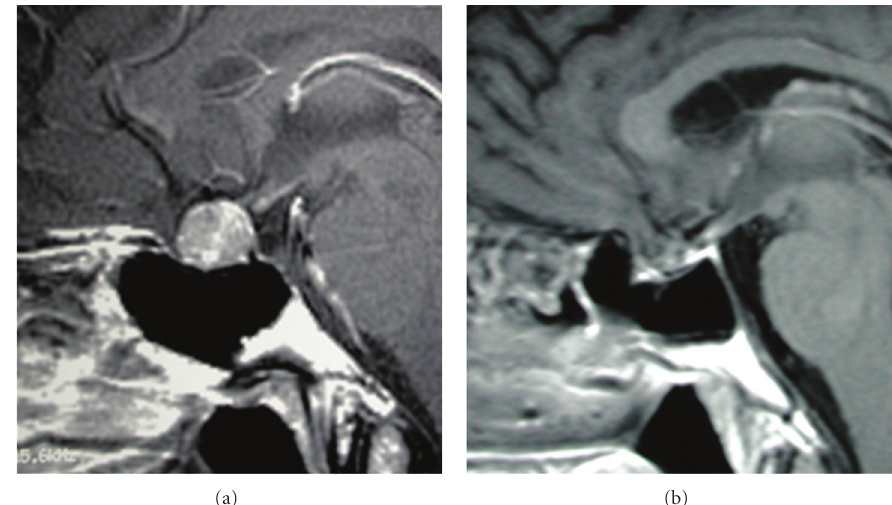
Figure 2: Contrast enhanced MRI sagittal view showing an intrasellar pituitary adenoma (a) that could be completely removed with surgery (b). Biochemical remission was also